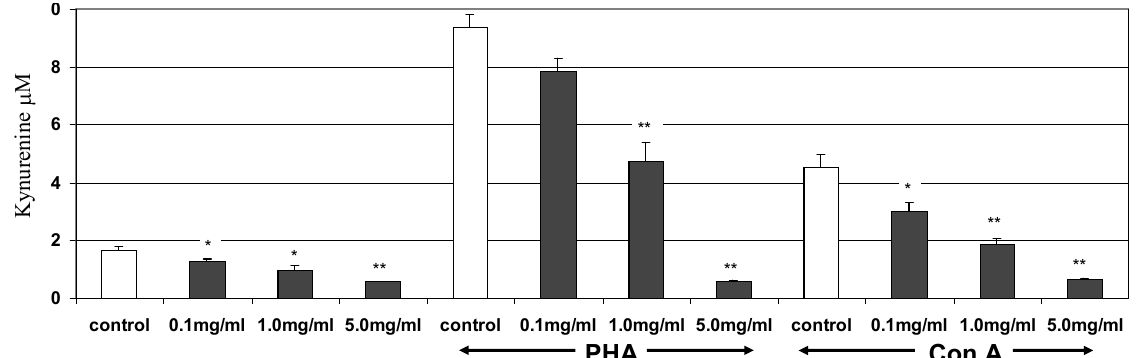
Figure 2: Concentration of kynurenine in supernatants of peripheral blood mononuclear cells unstimulated (left) or stimulated with mitogens phytohaemagglutinin (PHA; middle) and concanavalin A (Con A; right) with (black bars) or without (white bars) addition of 3 different concentrations of Nigella sativa seeds extracts for 48 hours ( ∗ P < 0.05, ∗∗ P < 0.001).